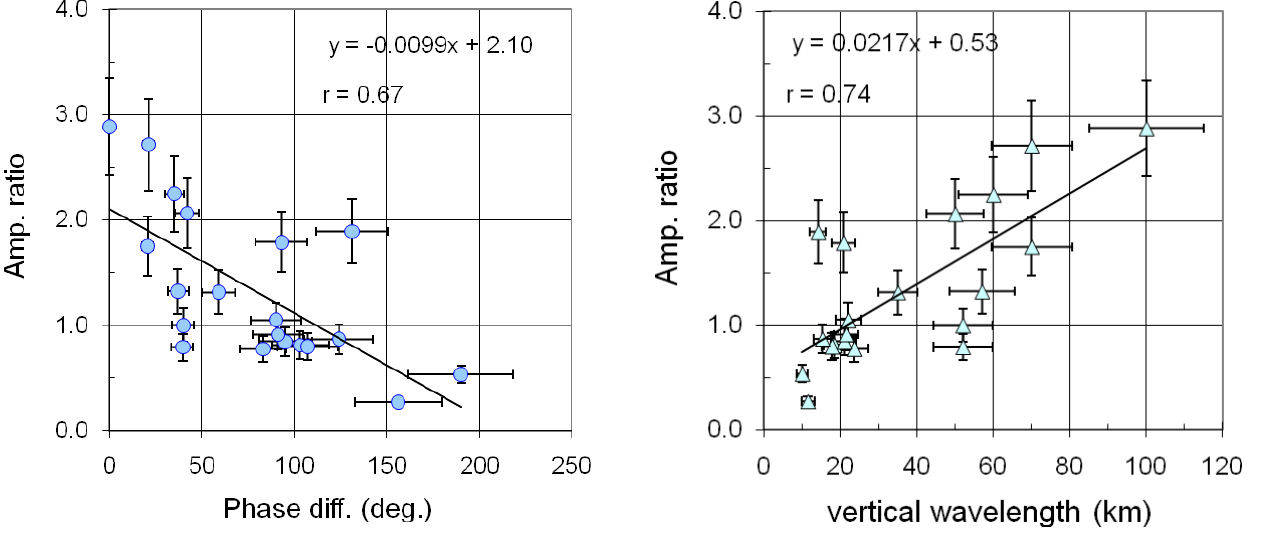
Fig. 5. Relation between the ratios of the O 2 and OH emission in- tensity variations and the vertical wavelengths. The straight line is a linear regression curve and “ r ” indicates the correlation